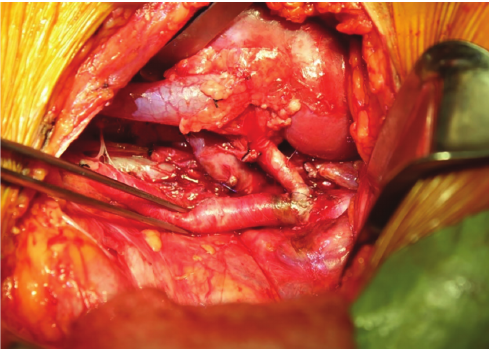
Figure 11 - Arterial and venous anastomosis